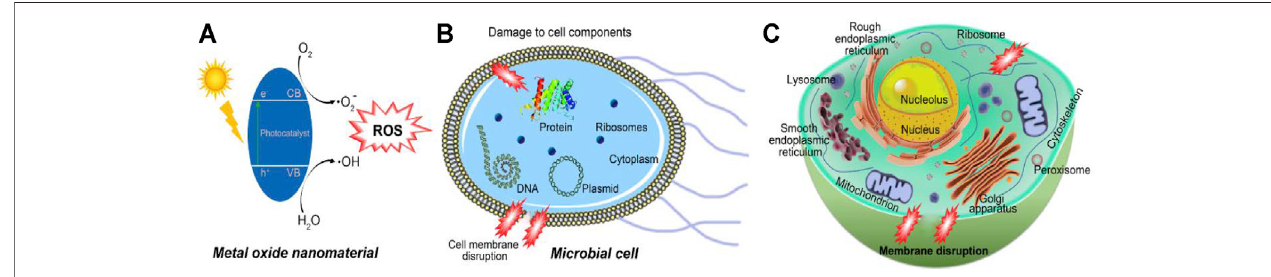
FIGURE 7 | Schematic representation of possible antifouling mechanisms of metal oxide nanomaterials (A) generation of ROS; effect of ROS on (B) a prokaryotic cell, and (C) a eukaryotic cell.